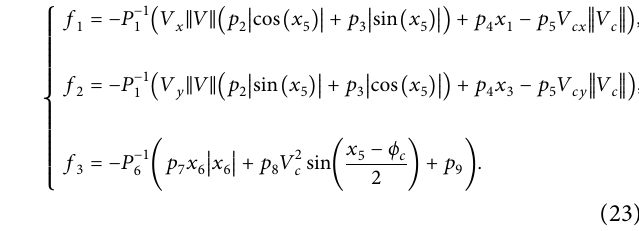
, x , x and x 1 2 3